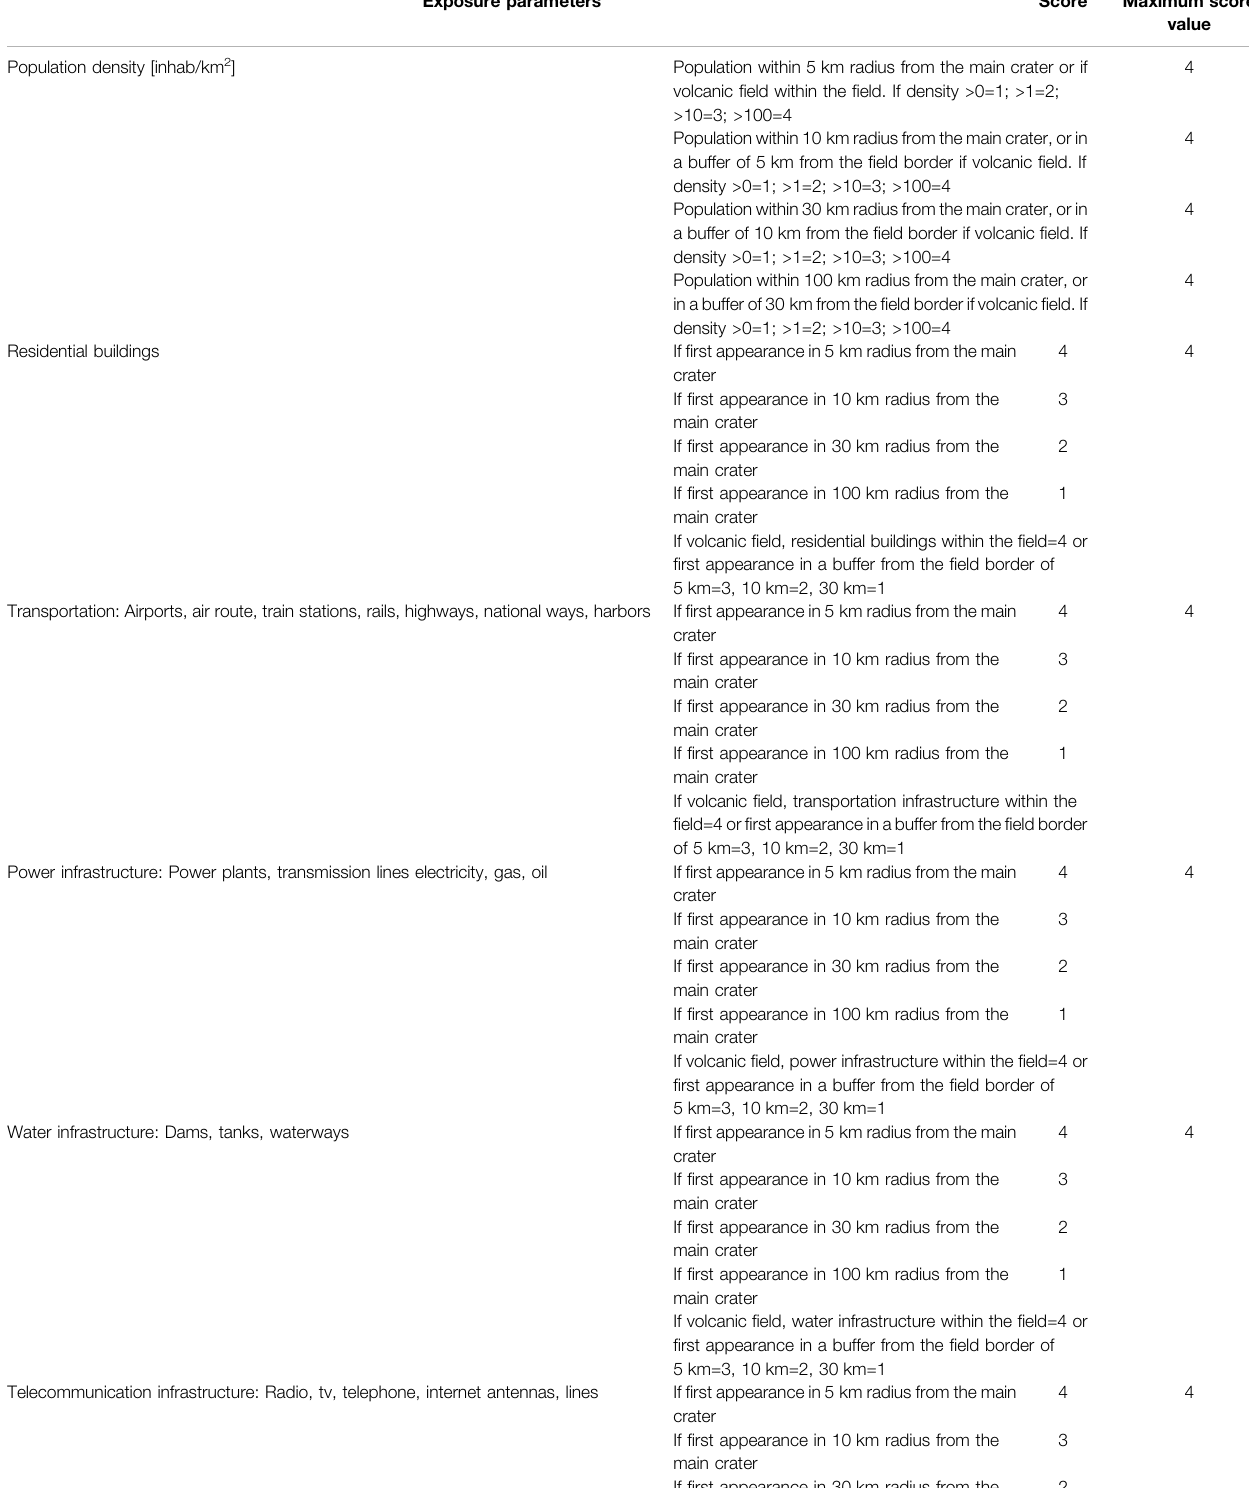
TABLE 2 | Exposure parameters evaluated in the new ranking strategy (adapted from Ewert et al.